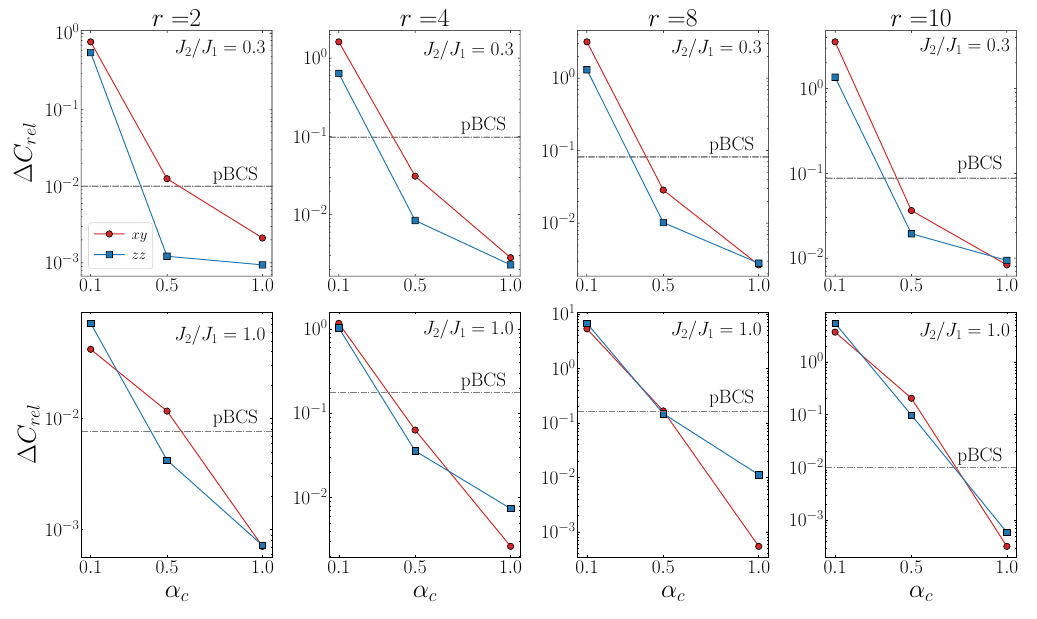
Figure 9: Relative error of the spin-spin correlation functions of the cRBM state with / J = 0.3 (upper panels) and J respect to the exact values, for J 2 1 panels). Results for C zz ( r ) (blue squares) and C x y ( r ) (red circles) are shown as a function of α , for several distances r on a N = 20 sites chain. The results of the c (spin-isotropic) pBCS wave function are also reported for